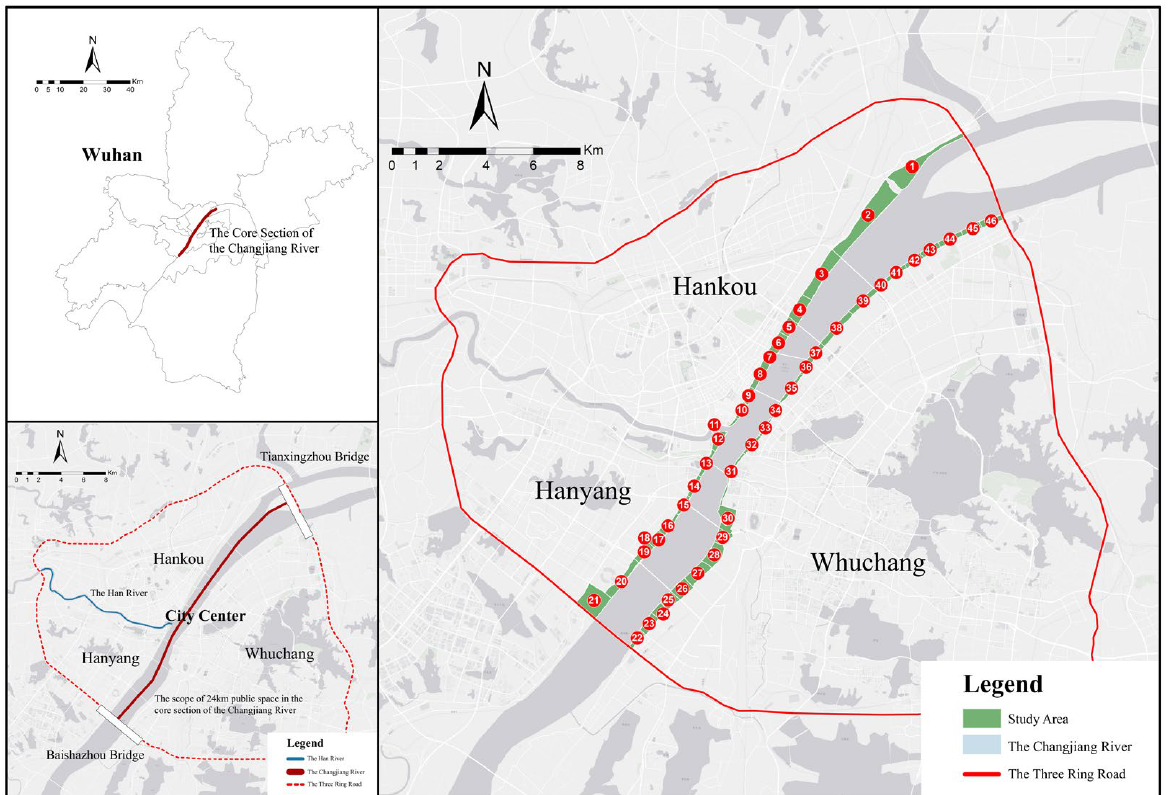
Figure 1. The research area and research units. Table 1. The research unit information.